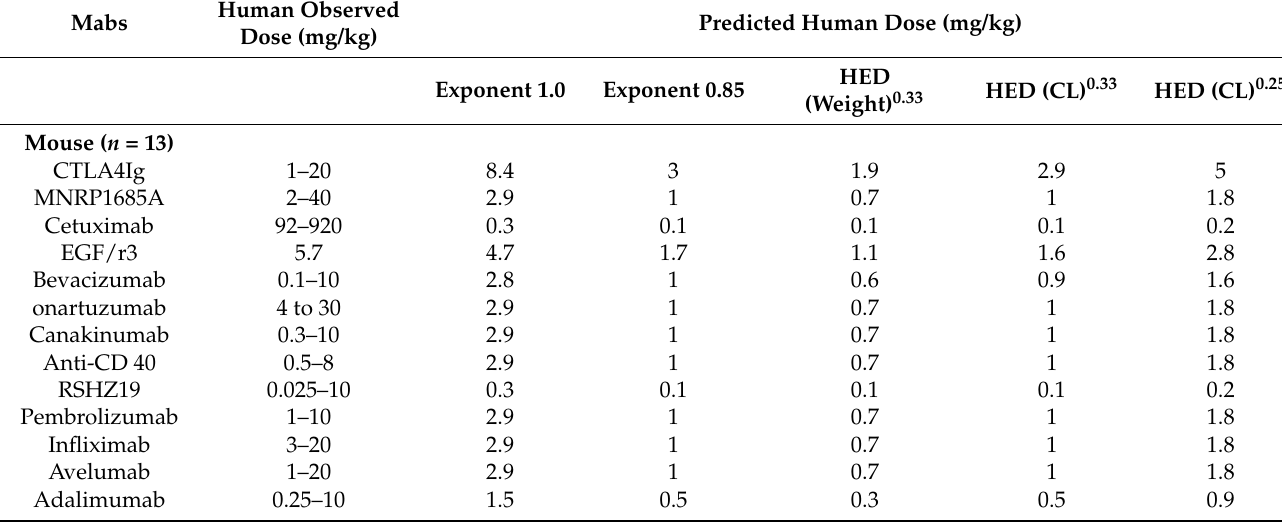
Table 3. Observed and predicted human dose by different